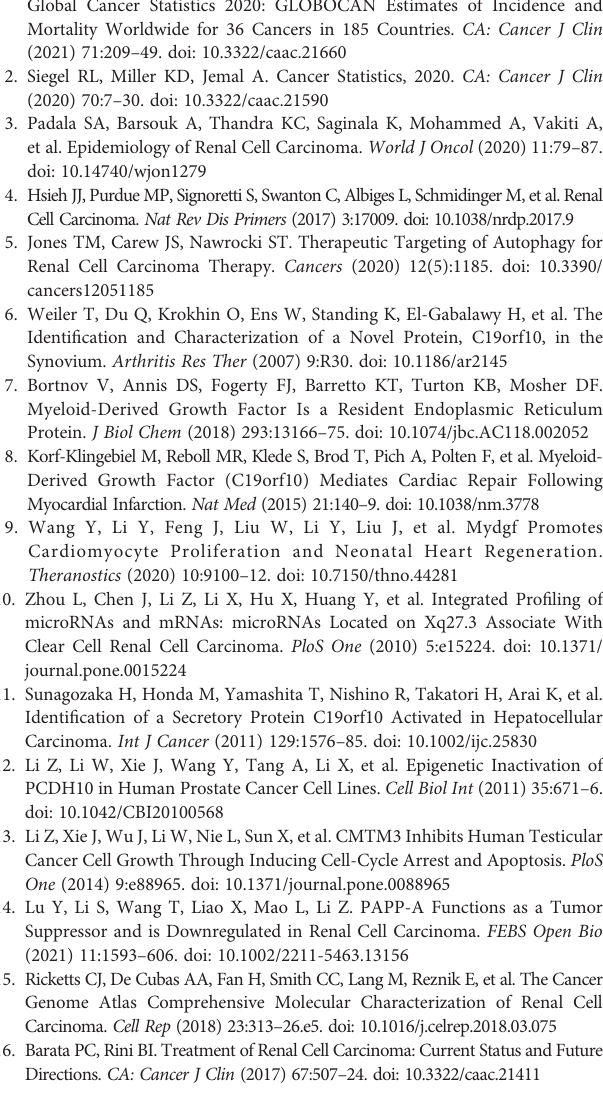
Supplementary Table 1 | Univariate and multivariate Cox regression analyses of clinical factors for RFS survival in KIRC (TCGA dataset). Abbreviations: HR, hazard ratio; CI, con fi dence interval; TNM, Tumor node metastasis.